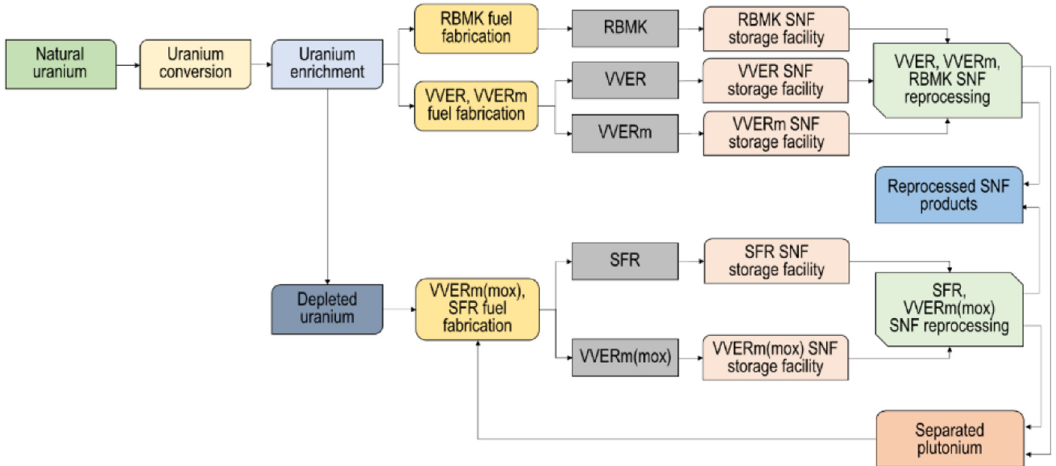
Fig. 1. Key components of the two-component NES infrastructure considered in